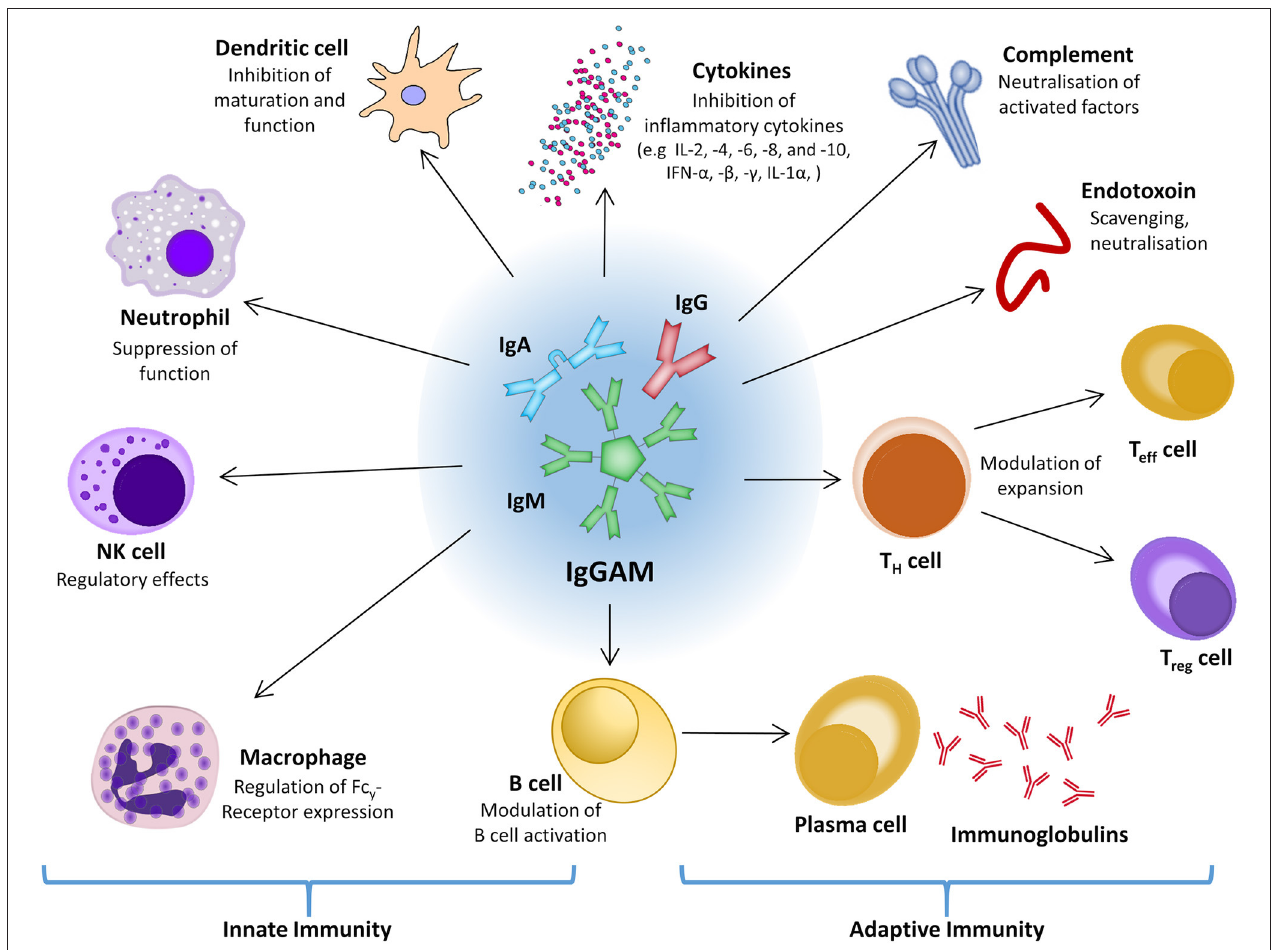
FIGURE 4 | The central role of IgGAM in the innate and adaptive immune response. IFN, interferon; Ig, immunoglobulin; IgGAM, immunoglobulin G/A/M; IL, interleukin; NK cell, natural killer cell; T eff cell, effector T cell; T H cell, helper T cell; T reg cell, regulatory T cell.